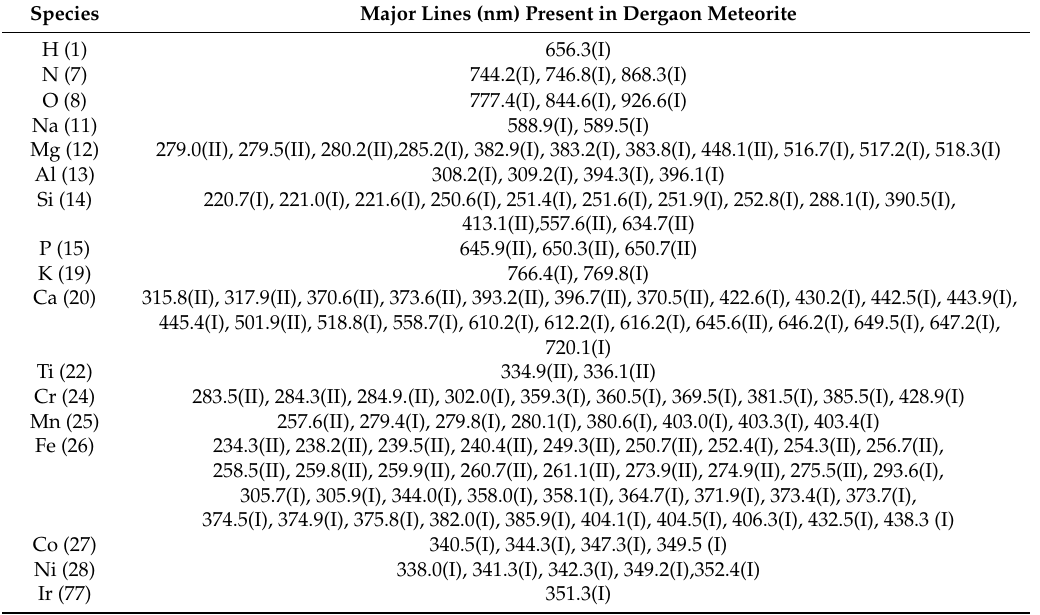
Table 1. Spectral lines observed with laser spectroscopy of Dergaon